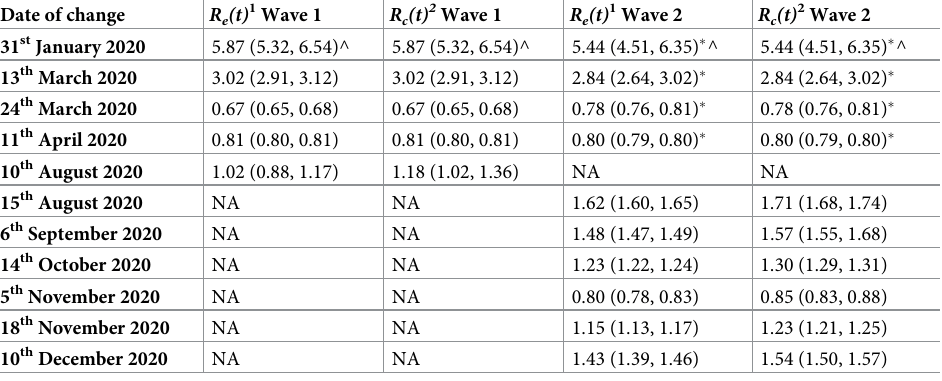
Table 5. Posterior estimates for effective, R e (t), and control, R c (t) reproduction numbers during 2020. Wave-one transmission rate estimates use data captured during the first wave only, whereas wave-two uses rates were estimated using data captured from the whole epidemic (see main text for further details). The final interval ended on 31 st December